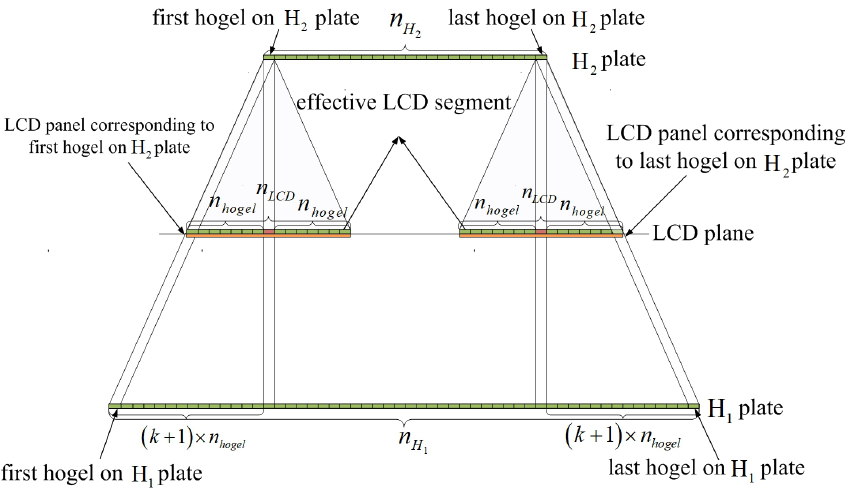
Figure 7. Determination of the hogel number for holographic element-based EPISM methods at k = 1. Introducing an index k , k represents the ratio of the distance from the LCD panel to virtual H 1 plate and H 2 plate, and k = L 1 . According to the geometric relationship, when k = 1, the hogel L 2 corresponding to the adjacent segment of the LCD panel is separated by one hogel. When L 1 and L 2 are not equal, let k be a positive integer; this means that the adjacent segment of the LCD panel has corresponding hogels on H 1 plate. The interval hogel number between adjacent hogels is exactly equal to k